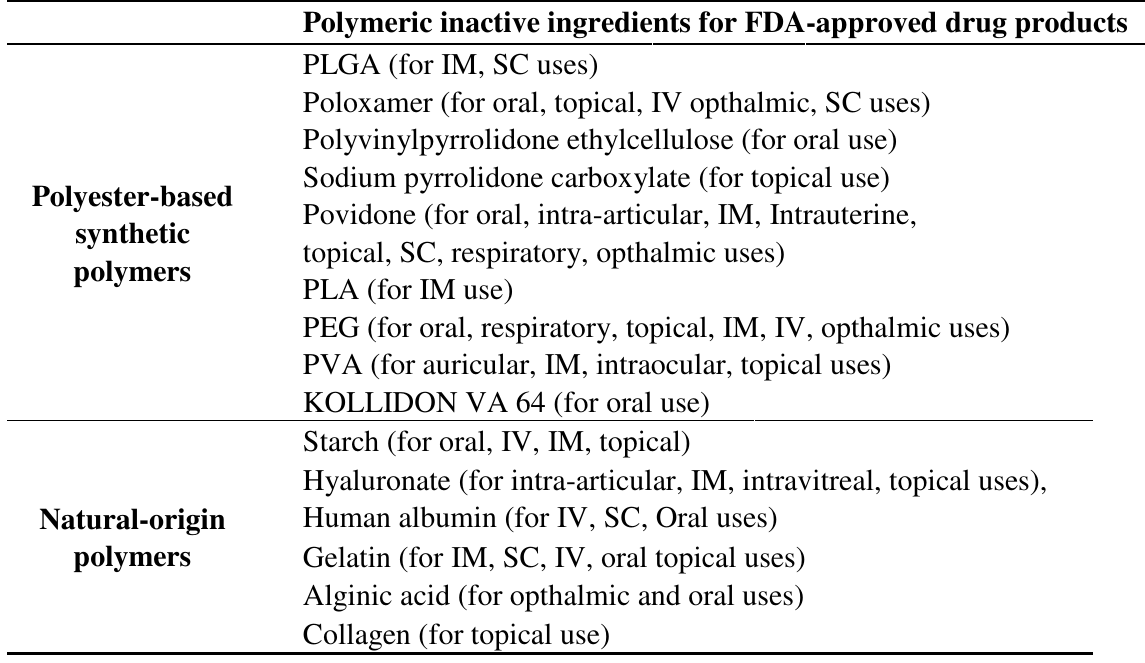
Table 1. Polymeric inactive ingredients for FDA-approved drug